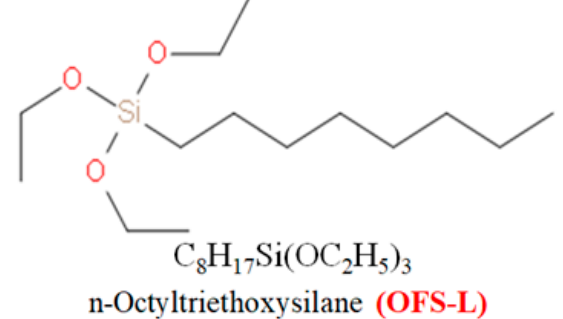
Figure 1. Chemical structure of Silanes.